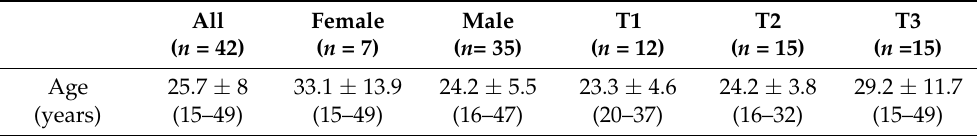
Table 1. Mean ± SD of the age variable in all sailors, females, males, and performance groups (T1, T2, and T3).